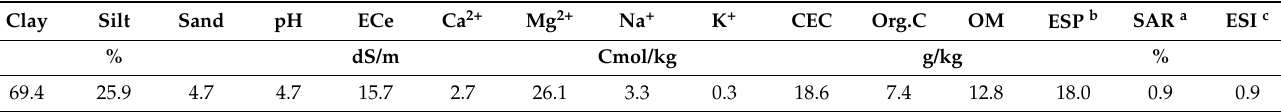
Table 1. Initial physico-chemical characteristics of soil in the columns.